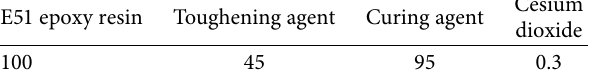
Table 1: Proportion of binder.